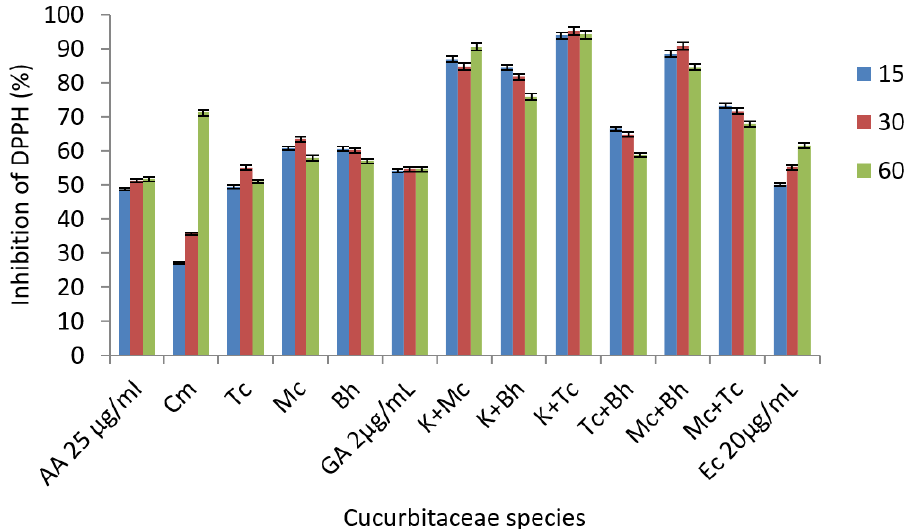
Figure 5. DPPH radical scavenging activity; where AA- ascorbic acid, Cm - C. metuliferus , Tc - T. cucumerina , Mc - M. charantia, Bh- B. hispida, GA-gallic acid, Ec- (−) -epicatechin. The error bars represent ±standard deviation of three